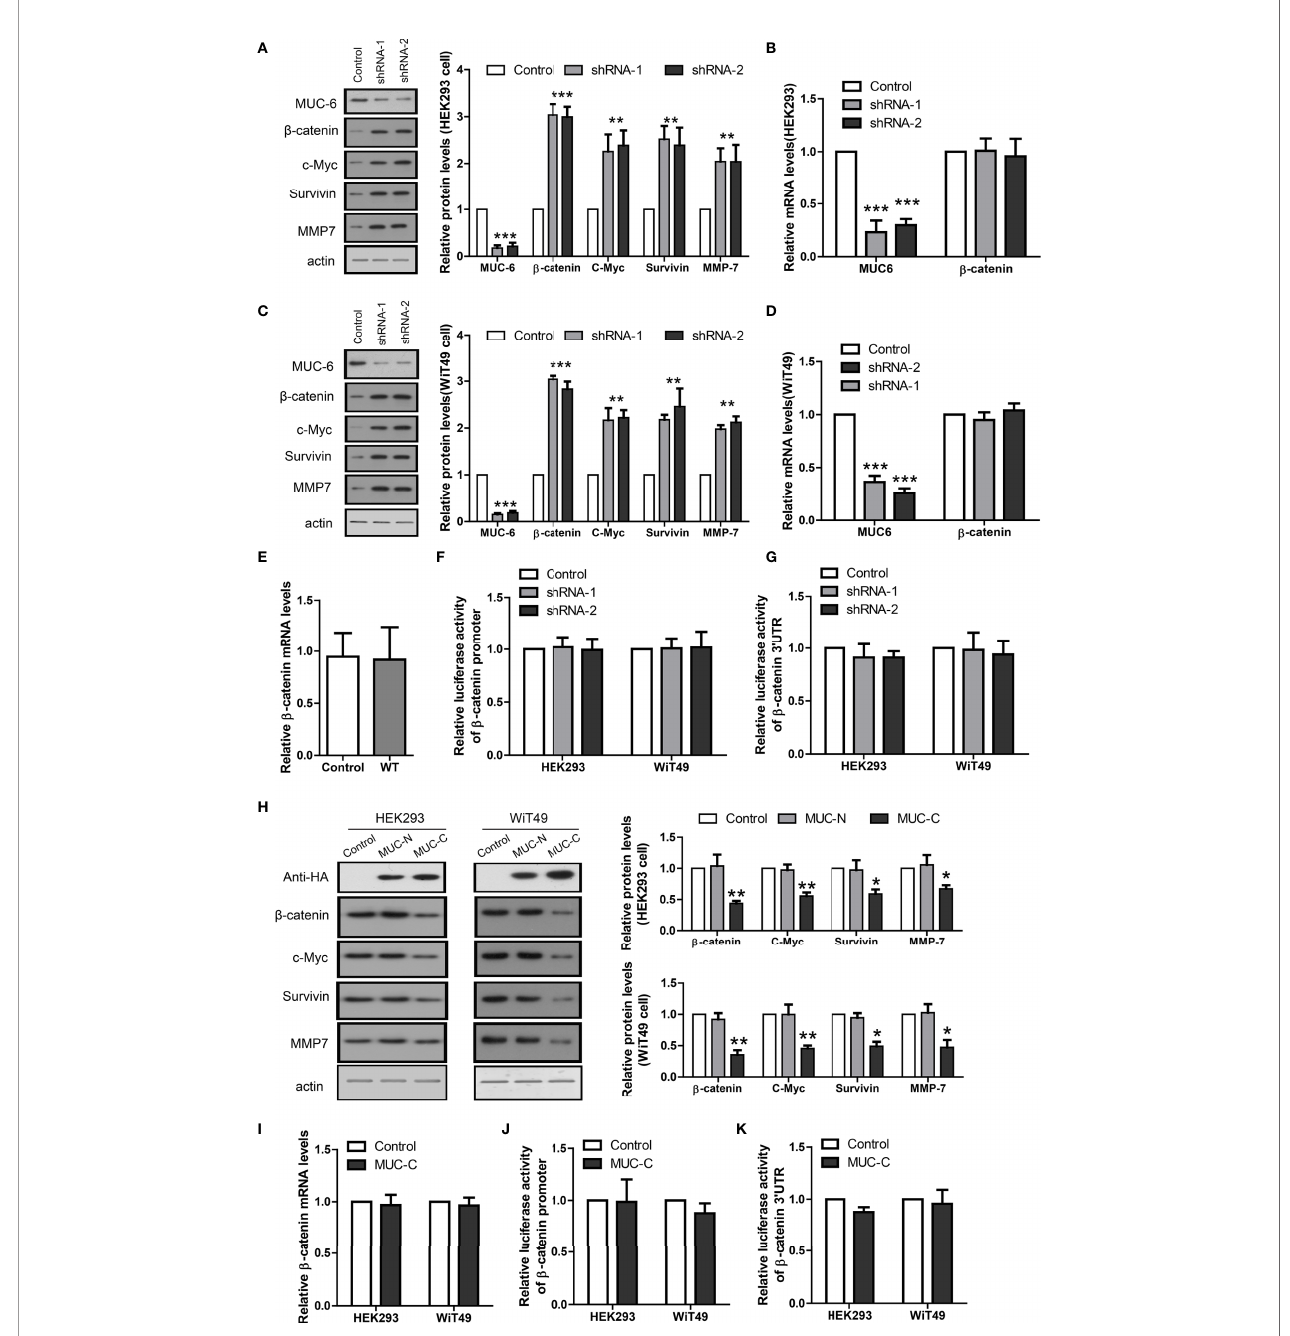
FIGURE 4 | MUC6 reduces b -catenin protein level. (A) Immunoblots showing protein levels of MUC6, b -catenin, c-Myc, Survivin and MMP7 in HEK293 cell infected with indicated shRNAs. (B) Real-time PCR results showing the mRNA levels of MUC6 and b -catenin in HEK293 cell infected with indicated shRNAs. (C) Immunoblots showing protein levels of MUC6, b -catenin, c-Myc, Survivin and MMP7 in WiT49 cell infected with indicated shRNAs. (D) Real-time PCR results showing the mRNA levels of MUC6 and b -catenin in WiT49 cell infected with indicated shRNAs. (E) Real-time PCR results showing b -catenin mRNA levels in 12 pairs of WT tissues. (F) Luciferase assays showing the activity of b -catenin promoter in cells infected with indicated shRNAs. (G) Luciferase assays showing the activity of b -catenin 3 ’ UTR in cells infected with indicated shRNAs. (H) Immunoblots showing protein levels of b -catenin, c-Myc, Survivin and MMP7 after over-expression of MUC6-N or C terminal in HEK293 and WiT49 cell lines. (I) Real-time PCR results showing b -catenin mRNA levels after MUC6-C over-expression in HEK293 and WiT49 cell lines. (J) Luciferase assays showing the activity of b -catenin promoter in HEK293 and WiT49 cell lines after MUC6-C over-expression. (K) Luciferase assays showing the activity of b -catenin 3 ’ UTR in HEK293 and WiT49 cell lines after MUC6-C over-expression. For all, *P<0.05; **P<0.01;